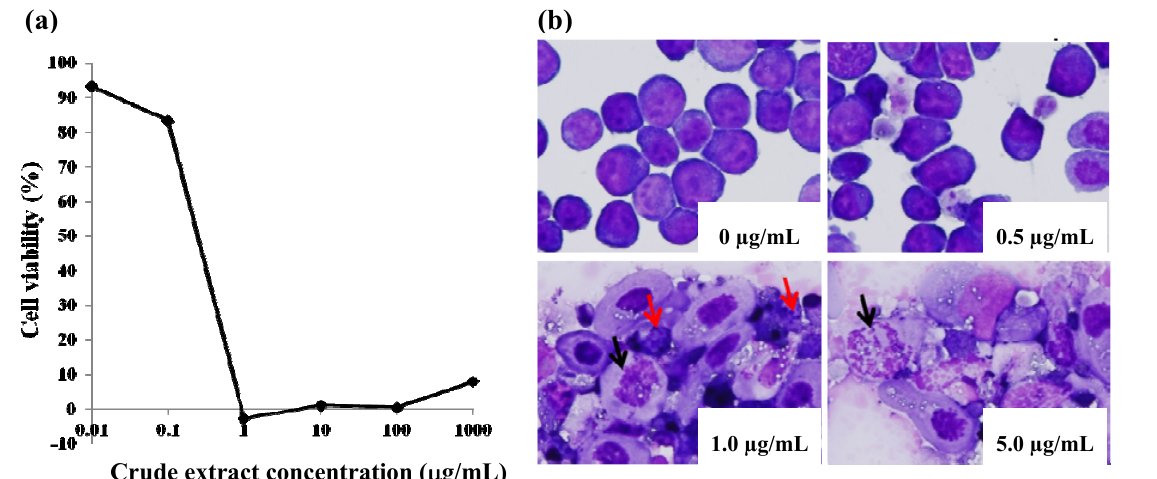
Figure 1. Cytotoxicity and morphologic assessment of apoptosis induction by Hyptis verticillata Jacq. crude extract. ( a ) Cytotoxicity against adult T-cell leukemia cell line, S1T; inhibitory concentration 50% (IC ) = 0.22  g/mL. ( b ) May-Grünwald-Giemsa 50 staining of S1T cells after incubation with the Hyptis extract at the dose indicated on each micrograph. Ten thousand cells were incubated alone or in the presence of increasing amounts of the extract. Disruption of nuclei (black arrows) and formation of apoptotic bodies (red arrows) are shown. Magnification